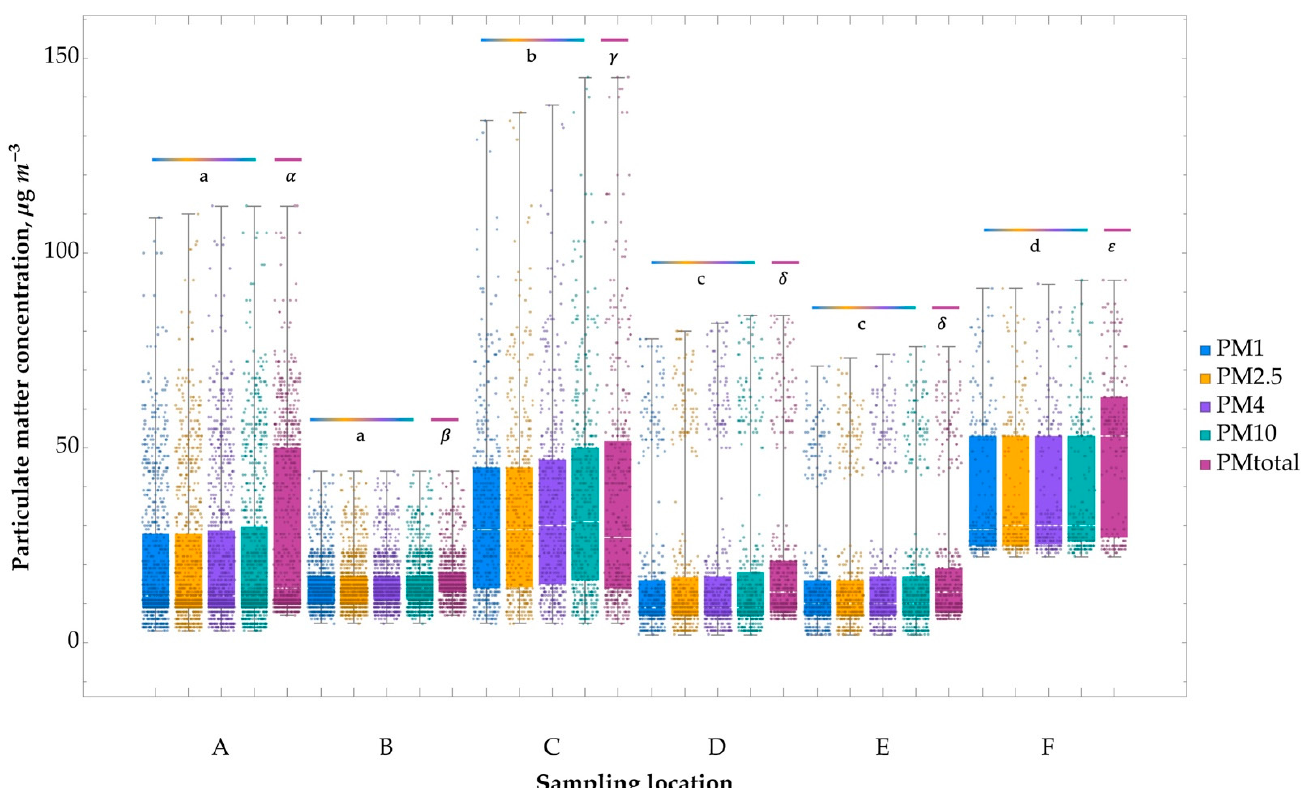
Figure 4. Box and whisker plot showing the particulate matter (PM) concentration at the selected locations. The whiskers represent the minimum and maximum values. Results with letters a–d (for PM 1 − PM 10 ) and symbols αβγδε (for PM total ) are significantly different from each other (Kruskal– Wallis test followed by Dunn’s posthoc tests at a significance level of 0.05). (A) “climbing wall”; (B) “swimming pool”; (C) “changing room at the swimming pool”; (D) “basketball/volleyball court”; (E) “badminton court”; (F) “entrance to the building”.